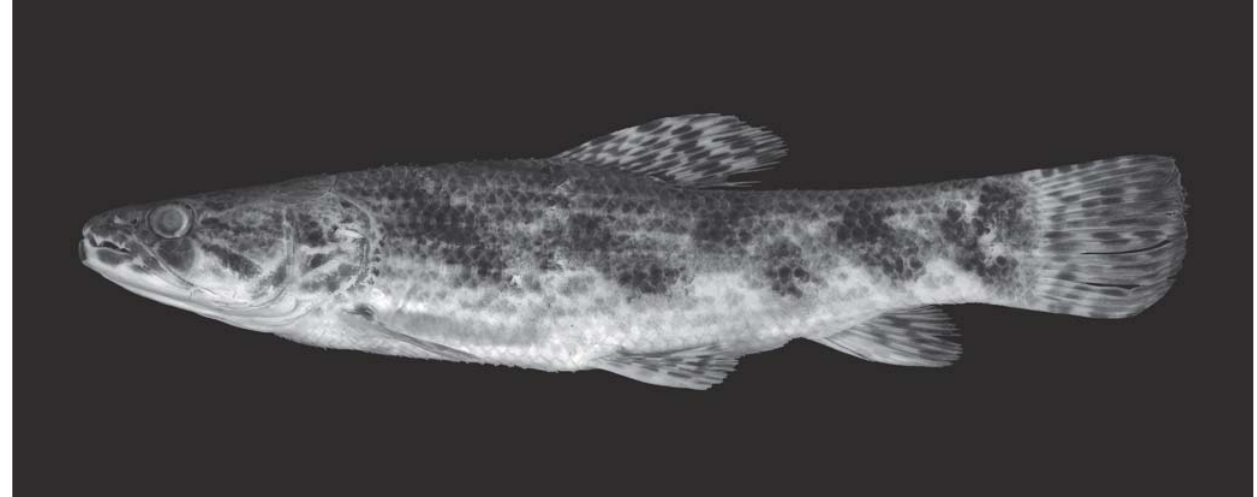
Fig. 10. Hoplias lacerdae , MZUSP 61748, 150.5 mm SL, rio Ribeira de Iguape, São Paulo State,